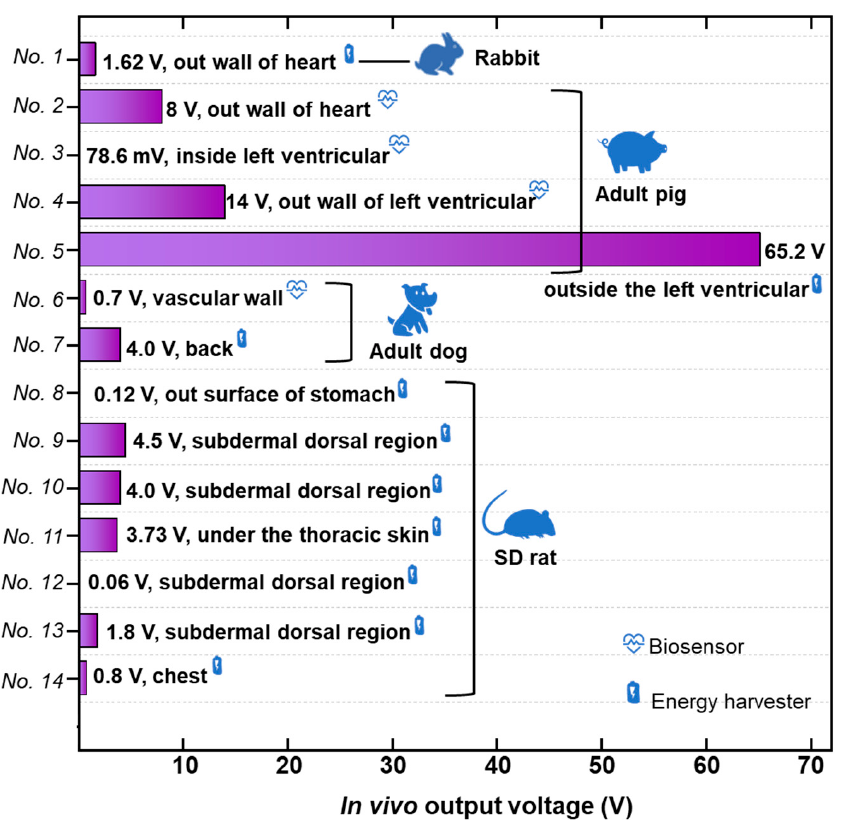
Figure 11. The in vivo output voltage of IMDs. Ref: No. 1-Shi et al., 2019 [92]. No. 2-Ma et al. 2016 [102]. No. 3-Liu et al. 2019 [103]. No. 4-Zheng et al. 2016 [3]. No. 5-Ouyang et al. 2019 [180]. No. 6-Ouyang et al. 2021 [93]. No. 7-Ryu et al. 2021 [5]. No. 8-Yao et al. 2018 [109]. No. 9-Jiang et al. 2018 [190]. No. 10-Zheng et al. 2016 [181]. No. 11-Zheng et al. 2014 [144]. No. 12-He et al. 2019 [58]. No. 13-Li et